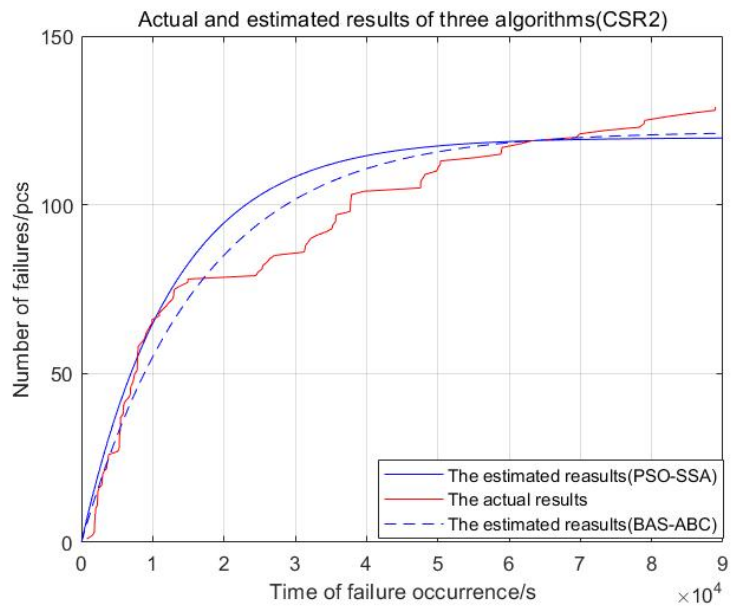
Figure 21. Actual and estimated results of two algorithms (CSR2).